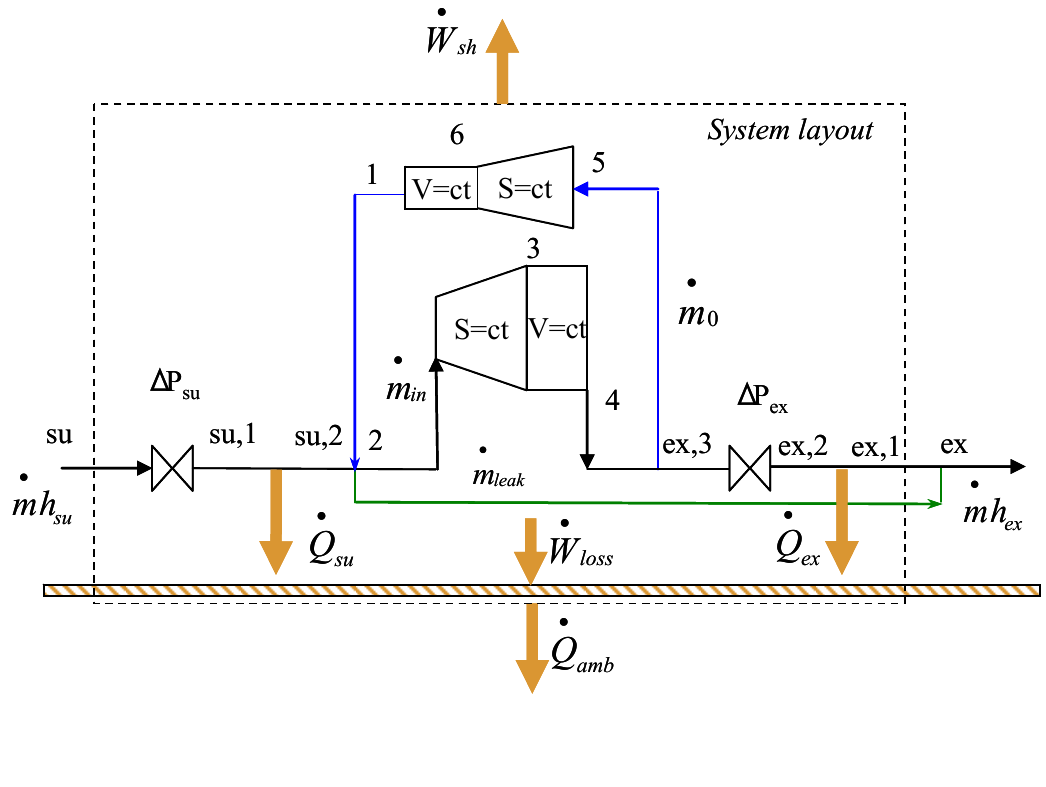
Figure 1. Schematic representation of the overall expander